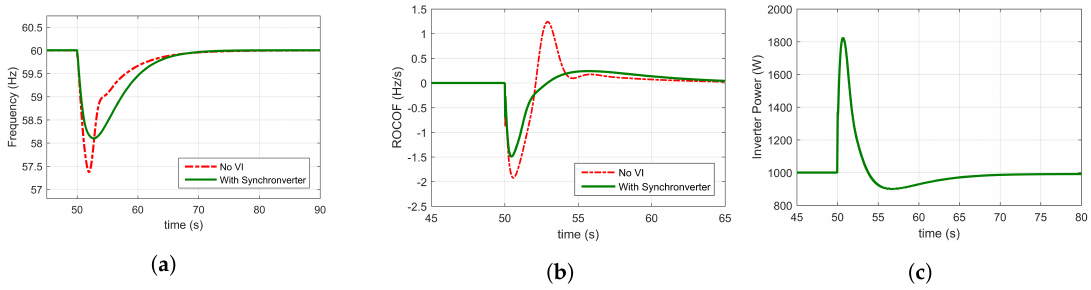
Figure 12. Simulation results from a synchronverter: ( a ) system frequency after a step-increase of 2 kW load; ( b ) ROCOF after a step-increase of 2 kW load; ( c ) increase in inverter power in response to system frequency decrease